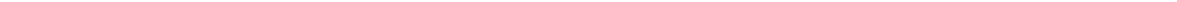
proximal (F 4 ) views (all mirrored). G . ? Palaeophasianus sp. (Geranoididae) from the early Eocene of Wyoming, USA, AMNH 5156; proximal end of right tarsometatarsus in proximal (G 1 ) and plantar (G 2 ) views. H . ? Palaeophasianus sp. from the early Eocene of Wyoming, USA, AMNH 5156; distal end of right tarsometatarsus in distal (H 1 ) and plantar (H 2 ) plantar views (H 1 mirrored). I . Palaeophasianus meleagroides Shufeldt, 1913 (Geranoididae), holotype: AMNH 5128; proximal end of left tarsometatarsus in proximal view (mirrored). J . Extant Struthio camelus Linnaeus, 1758 (Struthionidae) from the early Eocene of Wyoming, USA, SMF 2438; proximal end of right tarsometatarsus in plantar view. In C 3 , D 3 , F 3 , H 1 , and H 2, the tarsometatarsal trochleae are numbered. Scale bars 10